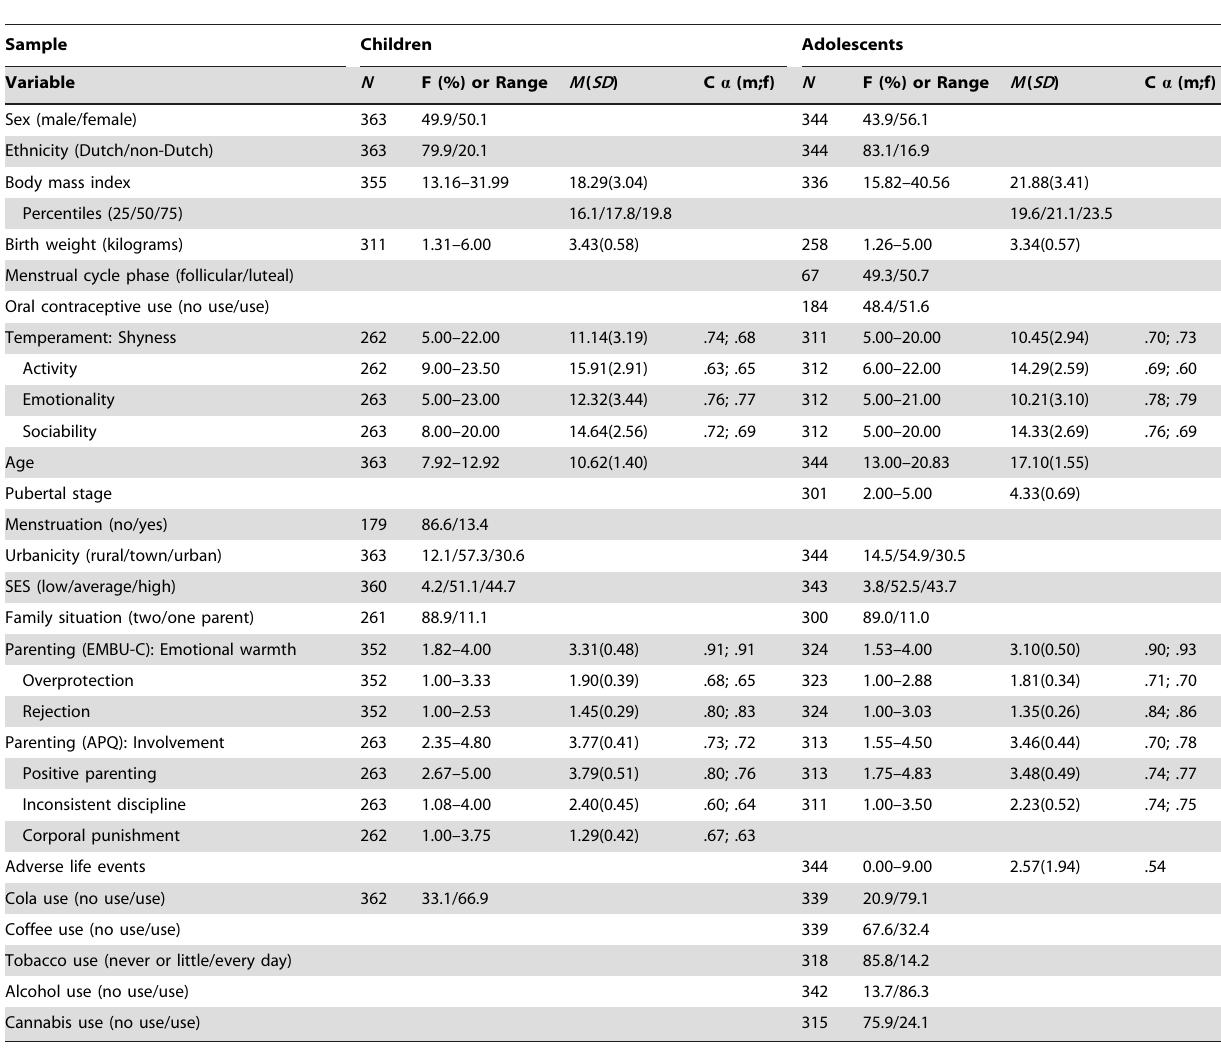
Table 1. Descriptive statistics of all potential determinants of stress